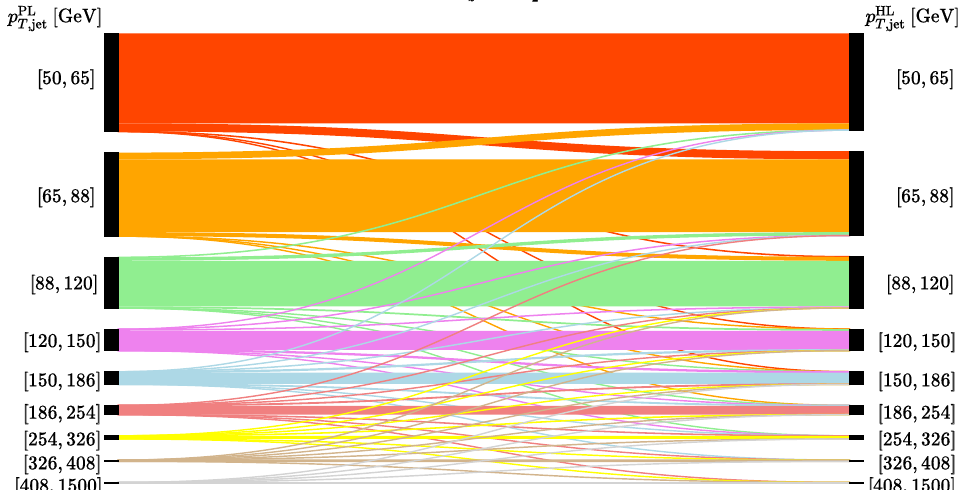
Figure 1. Illustration of cross-section migration between parton level and hadron level with respect Loading [MathJax]/extensions/MathMenu.js to the jet transverse momentum for the double-differential NLO + NLL 0 resummed distribution of λ 1 in Z +jet production. The used jet-radius parameter is R = 0 . 4 , the employed transfer matrix 2 corresponds to the case of all hadrons contributing at hadron